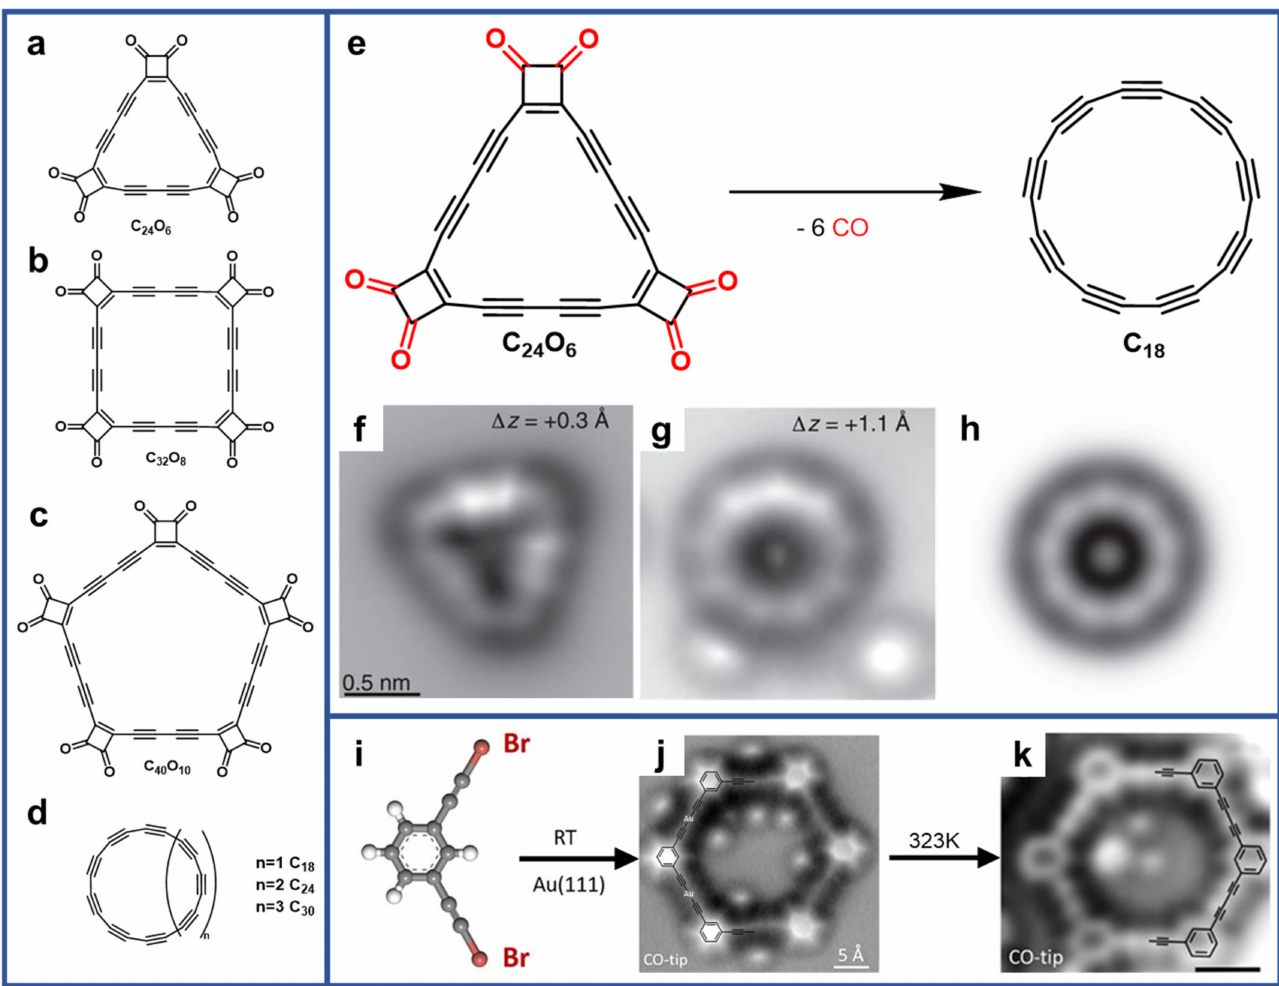
Figure 1. ( a – c ) Precursors to the ( d ) cyclo[ n ]carbon (n = 1, 2, 3), respectively. Reprinted with per- mission from Ref. [39]. Copyright 1993, American Association for the Advancement of Science. ( e ) Reaction scheme for the on-surface formation of C 18 . ( f , g ) Nc-AFM images of C 24 O 6 and C 18 recorded with a CO-functionalized tip on the NaCl surface. ( h ) Simulated AFM image based on gas-phase DFT-calculated geometries, corresponding to the difference in probe height in Figure 1g. Reprinted with permission from Ref. [40]. Copyright 2019, American Association for the Advance- ment of Science. ( i ) Structural model of 1,3-bis(2-bromoethynyl) benzene (BBEB). ( j ) Nc-AFM image of an organometallic intermediate attributed to (d-BBEB-Au) 6 and ( k ) graphdiyne-like macrocycles using a CO-functionalized tip. Reprinted with permission from Ref. [41]. Copyright 2018, American Chemical